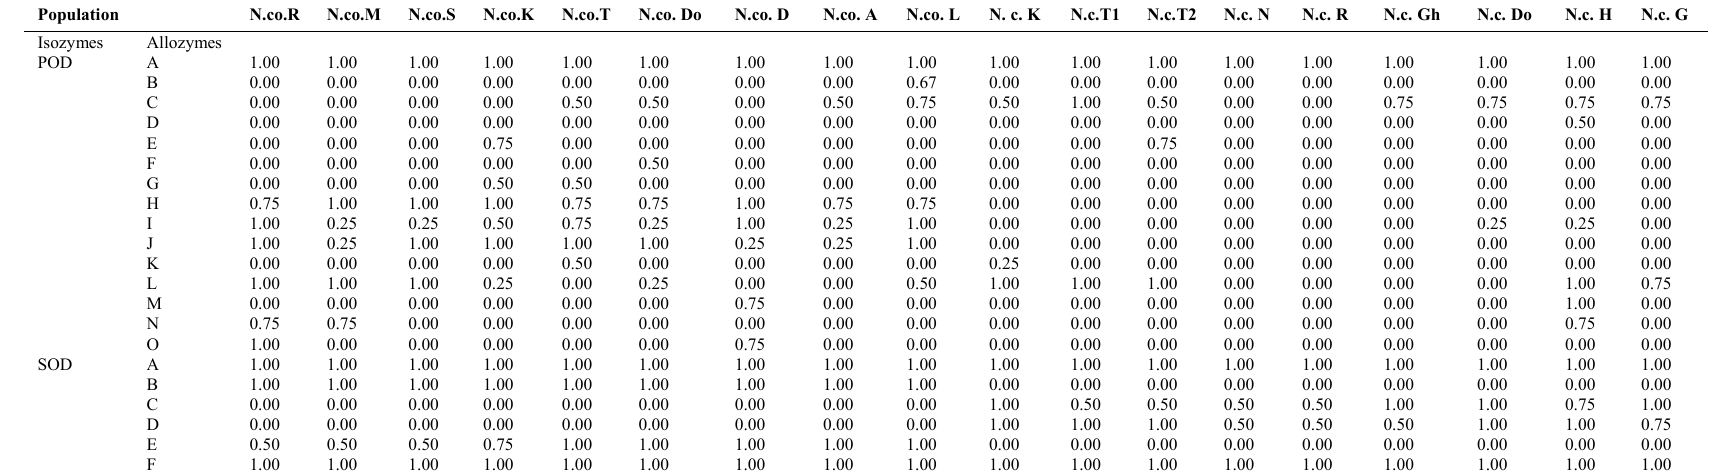
Table 2 Band frequencies for two enzyme systems among 18 populations of N. complanata and N. crispa in the north of Iran. For abbreviation of the populations see Table 1. Population